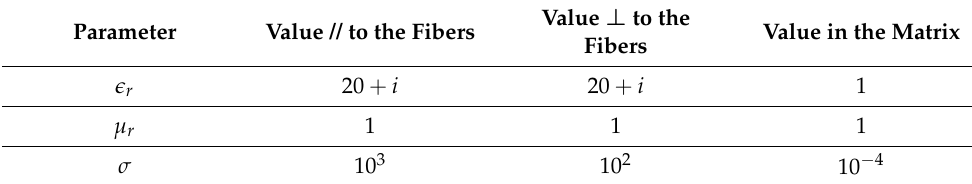
Table 1. Properties of the fiber and matrix phases in the parallel and perpendicular direction to the fibers. The notation//is used to refer to the direction parallel to the fibres, whereas ⊥ refers to the direction normal to the fibers. Value ⊥ to the Parameter Value // to the Fibers Value in the Matrix Fibers (cid:101) r 20 + i 20 + i 1 µ r 1 1 1 σ 10 3 10 2 10 −